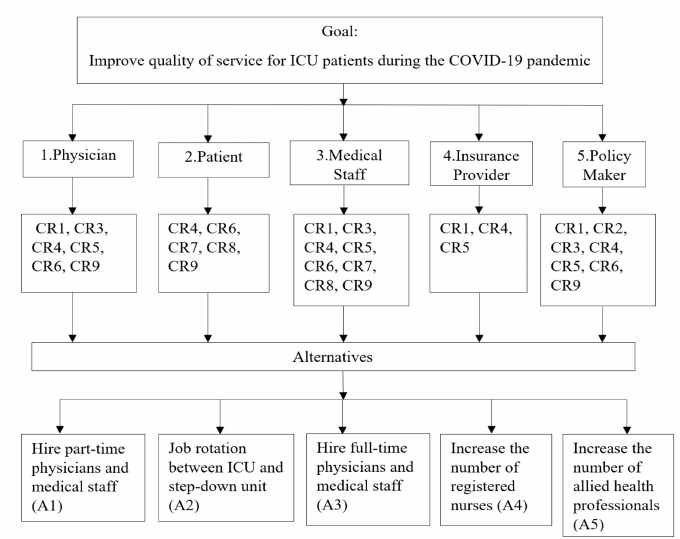
Figure A8. ERM ranking of